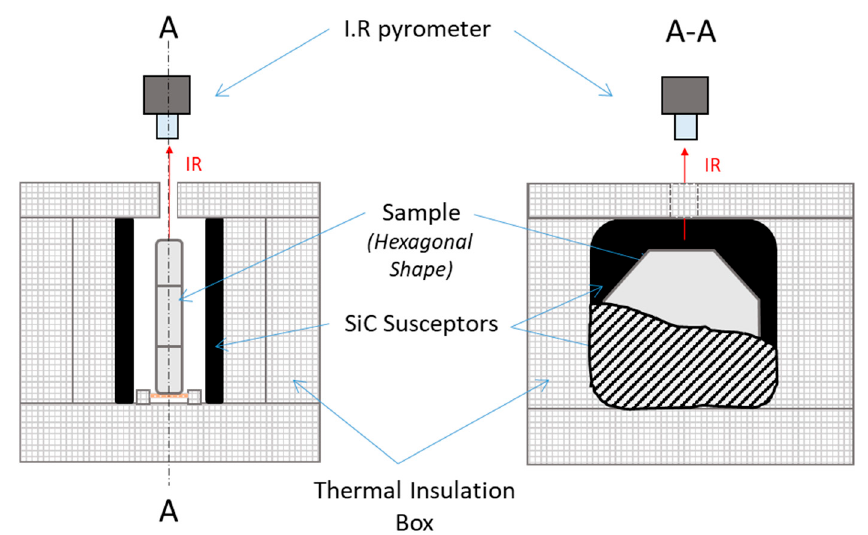
Figure 3. Assembly used to heat up the green ceramic sample into the 915 MHz single-mode cavity.